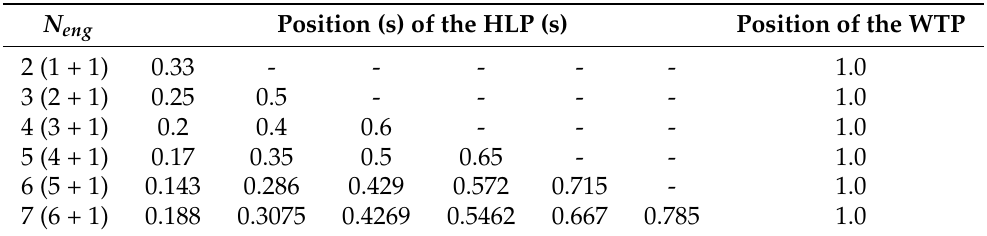
Table 1. HLP position considered in the parametric study on the effect of HLP weight (in % of the semi-span) per